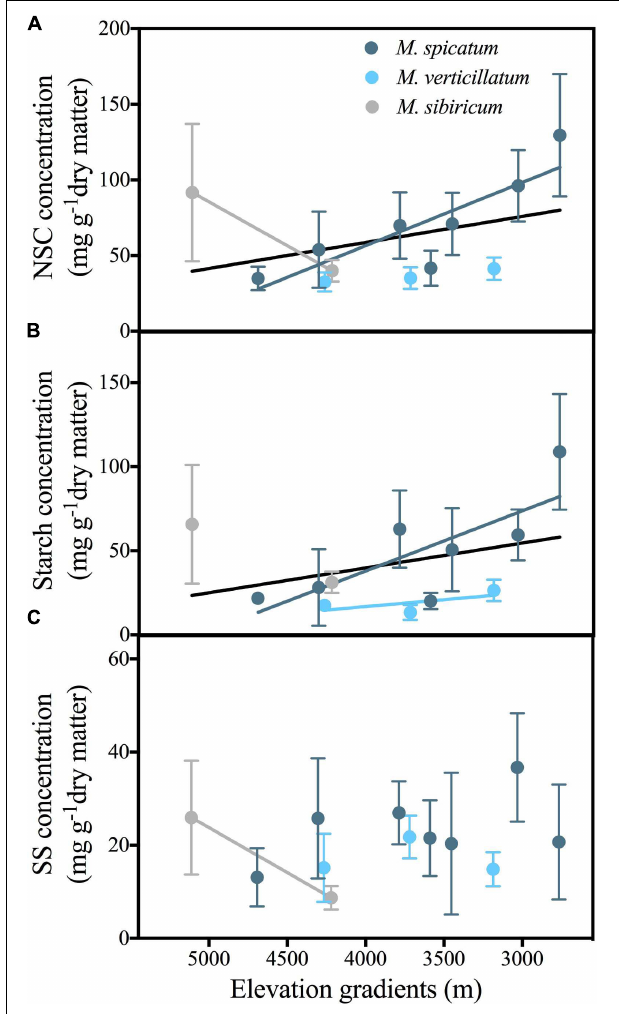
FIGURE 2 | Relationships of the non-structural carbohydrate (NSC) (A) , starch (B) , and SS (soluble sugars) of leaves (C) in response to elevation for three Myriophyllum species ( M. spicatum , M. verticillatum and M. sibiricum ) combined at the Qinghai-Tibetan Plateau, China. Black lines represent the combined regression lines of three Myriophyllum species. Only the significant relationships are presented. Please see Appendix S2 for statistical details. The data are presented with a mean ± 2 standard error. NSC = SS +